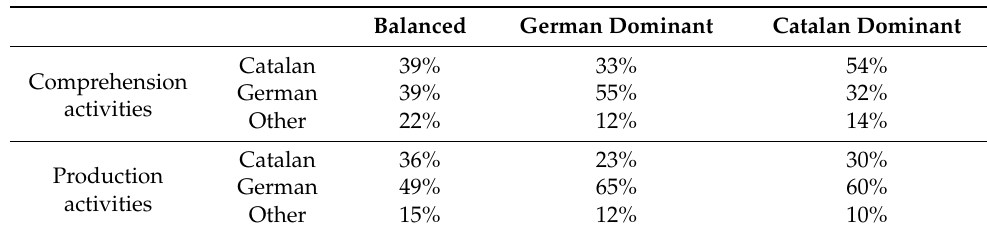
Table 11. Distribution of comprehension and production activities in Catalan, German (and L C ) according to language